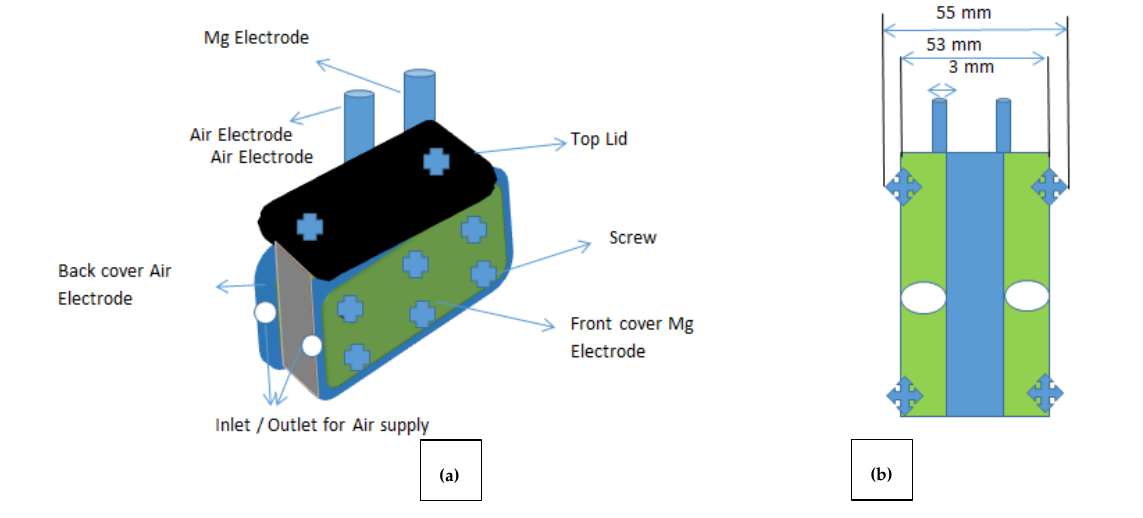
Figure 1. MAB configuration and arrangements: ( a ) overall schematics of the battery reflecting the electrode connections with air entry and exit points; ( b ) frontal view showing the internal dimensions of the geometry of the battery.